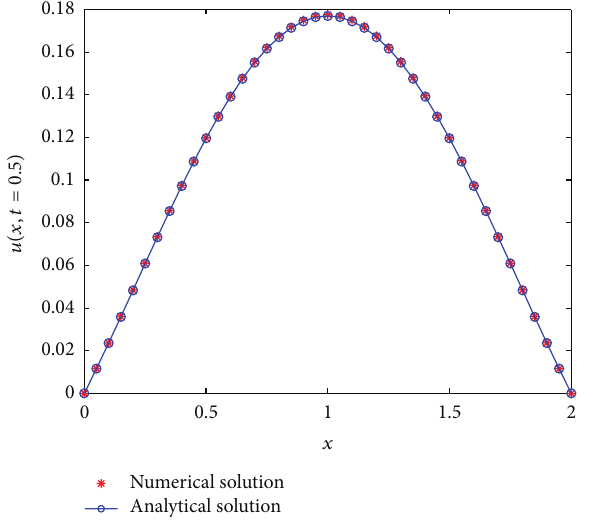
Figure 2: The comparison of the numerical solution with the analytical solution at 𝑡 = 0.5 . (𝜏 = 1/200, ℎ = 1/50)